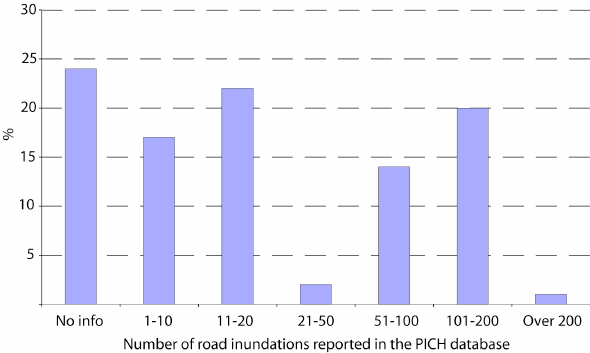
Figure 2. Distribution of the number of reported inundation events during the last 40 years in Fig. 2. Distribution of the number of reported inundation events the PICH database. during the last 40years in the PICH